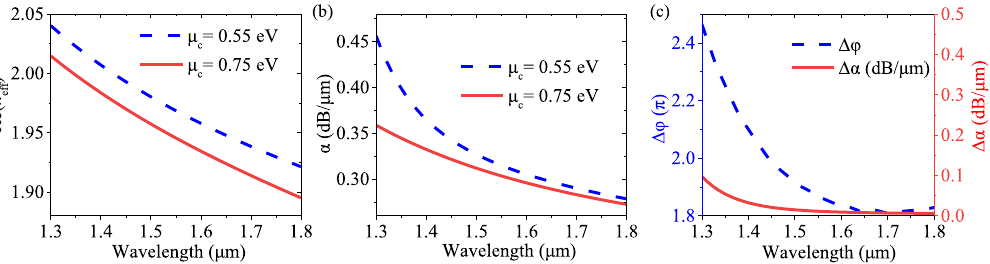
Figure 6: (a) – (c) Dependence of Re( n eff ), α , Δ φ and Δ α of the proposed GPM on the operating wavelength ranging from 1.3 to 1.8 μ m.